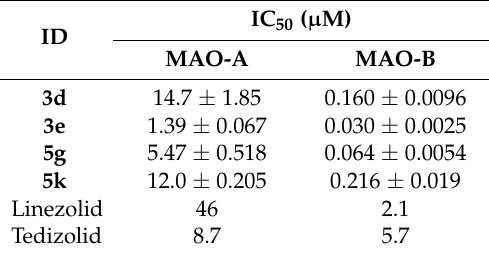
Table 3. The human monoamine oxidase (MAO) inhibition potencies of oxadiazole derivatives ( 3d , 3e , 5g , 5k ) and known